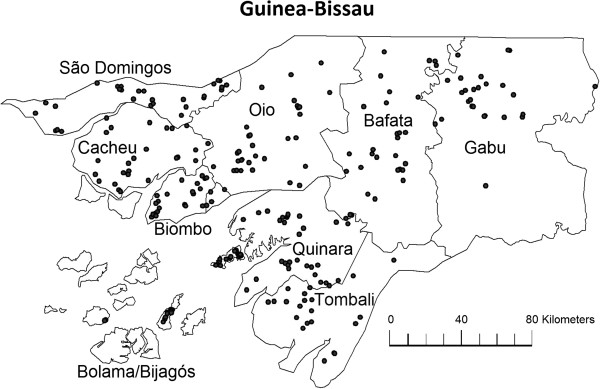
Map of regions in Guinea-Bissau. Villages included in the study marked as dots.